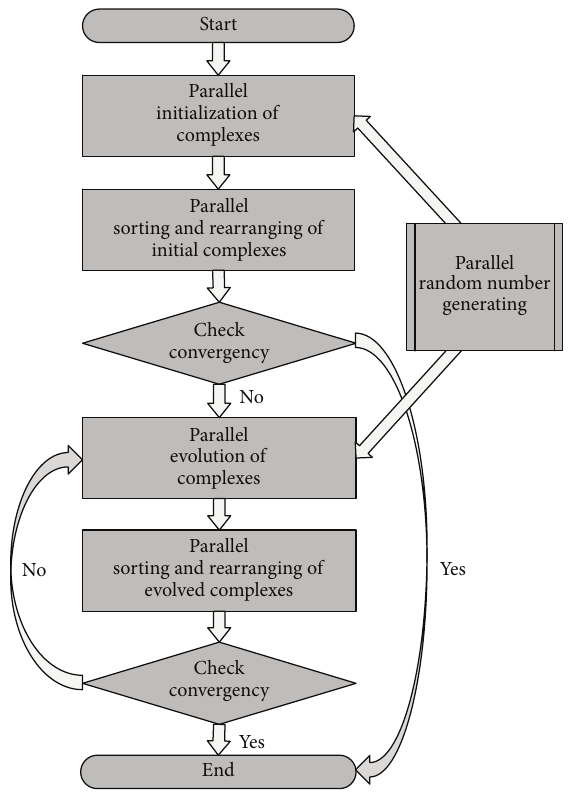
Figure 2: Flowchart of the parallel SCE-UA method.